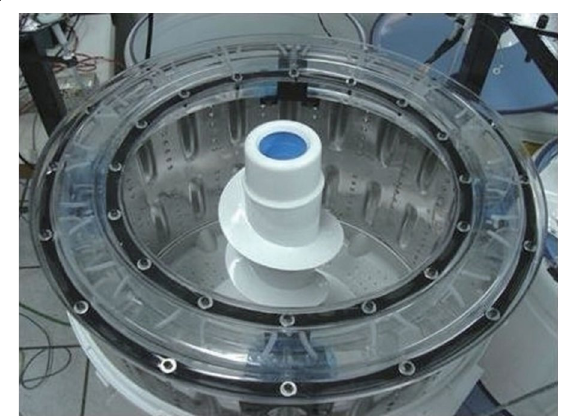
Figure 26 Classification of balancing actuators Figure 27 Balancing actuator for a washing